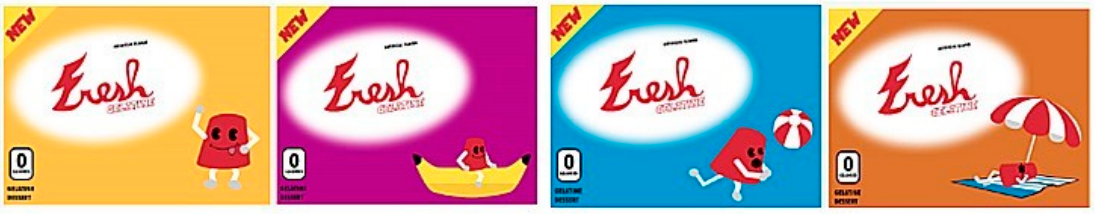
Figure 2. Label designs options to select in the prototype.